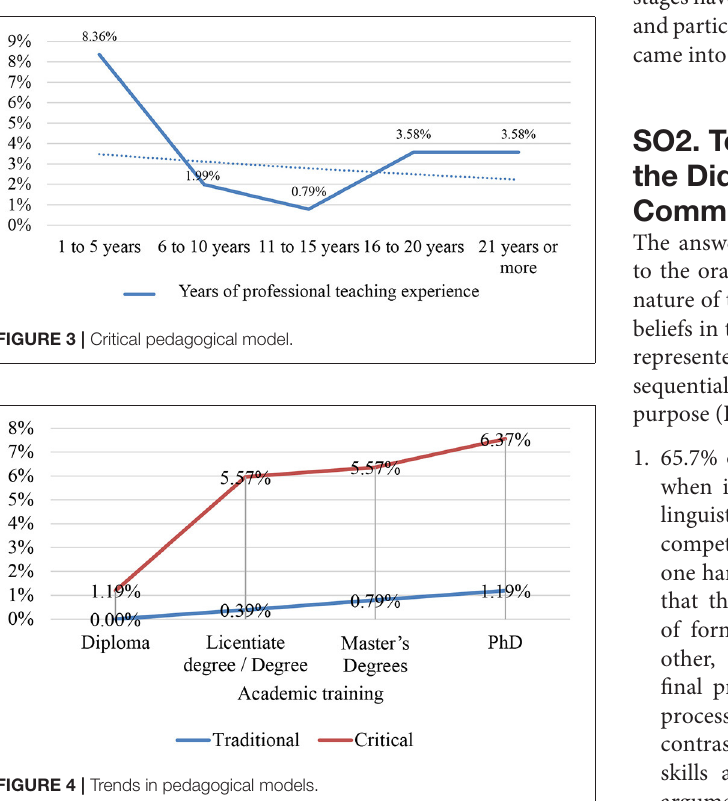
FIGURE 4 | Trends in pedagogical